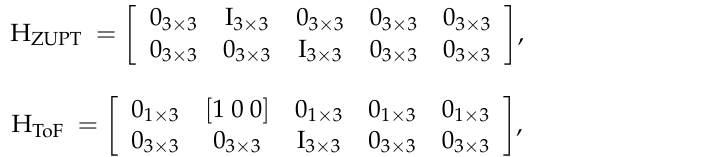
Figure 7. Effect of a significant heading variation in range and, subsequently, velocity measure- ment of the ToF distance sensor.